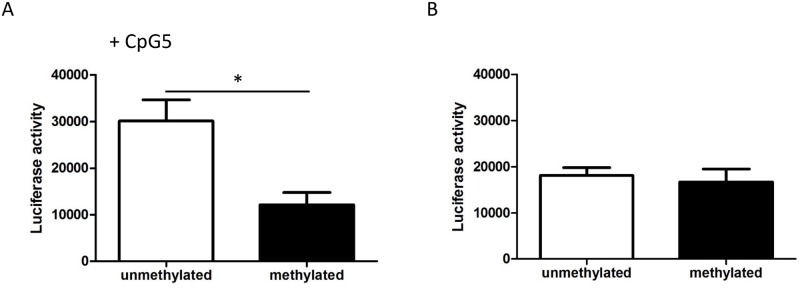
In vitro methylation of ANGPTL2 decreases promoter activity.In vitro methylation of ANGPTL2 target region containing CpG5 inhibited transcriptional activity, as measured by a luciferase reporter assay. Luciferase activity of methylated (M.SssI treated) and unmethylated constructs (A) containing the CpG5 site or (B) without. The assay was repeated 3 times and data are mean ± SEM. *: p<0.05 versus unmethylated (Unpaired t-test).